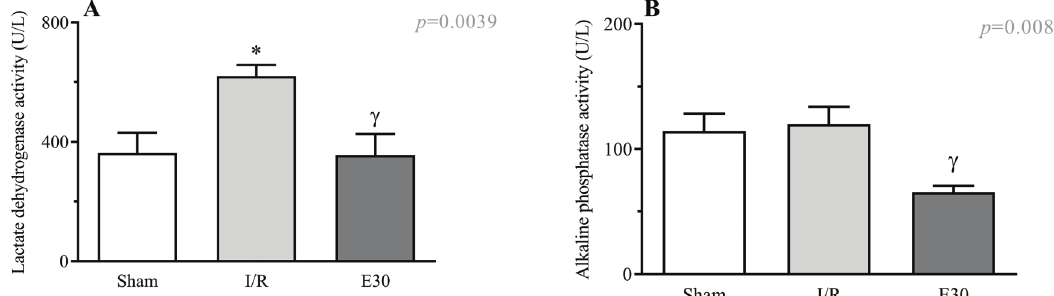
Figure 5 - Serum concentrations of lactate dehydrogenase (Panel A) and alkaline phosphatase activity. (Panel B). A group of rats had their superior mesenteric arteries clamped (45 min), followed by intestinal reperfusion (2h). Estradiol (180 m g/kg, i.v.) was administered 30 min after induction of intestinal ischemia (E30). Sham-operated rats were used as control. Data are expressed as the mean ± standard error of the mean (SEM) from 8 animals. Panel A: * p =0.0081 compared with sham; g p =0.0066 compared with I/R. Panel B: g p =0.0088 compared with I/R. I/R, ischemia and